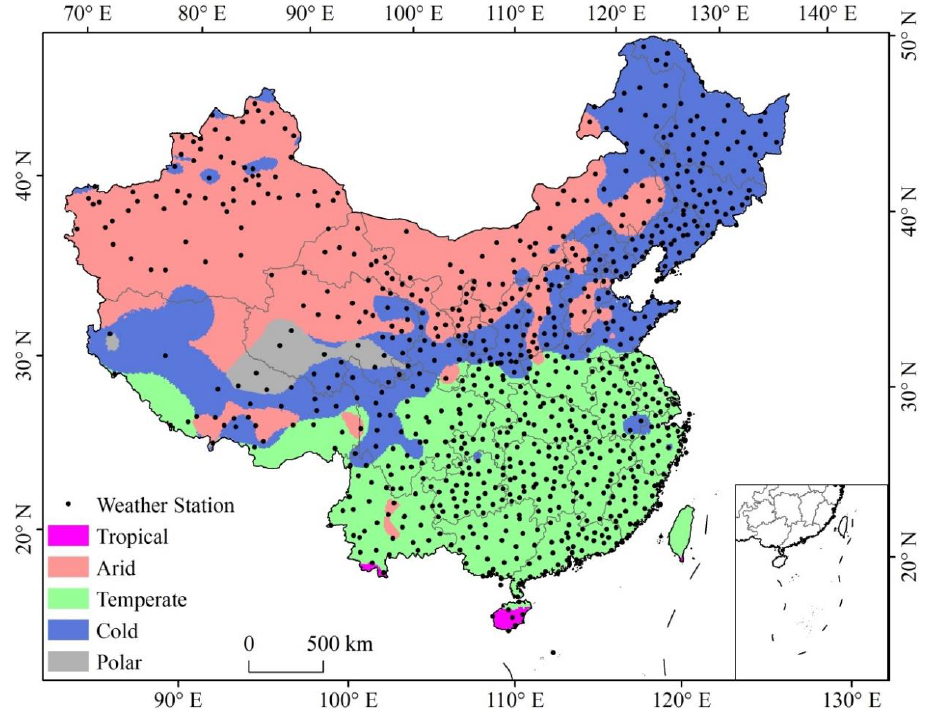
Figure 1. Distribution of meteorological stations.